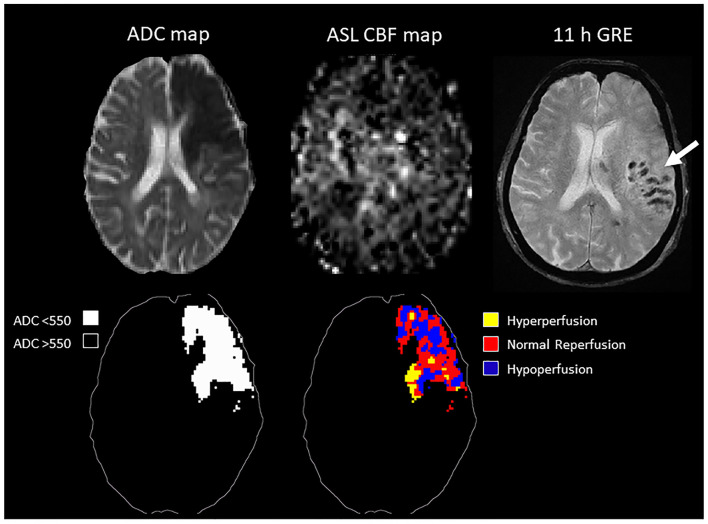
Top: MRI of an 89 year old patient with MCA occlusion. IV tPA was given 2 h from onset, followed by clot retrieval at 5.5 h from onset. Post-treatment ASL showed inhomogeneous reperfusion, and subsequent hemorrhage was observed in GRE at a later time point. Bottom: schematic drawing of the ADC-thresholded lesion volume, and the reperfusion volume distribution within the lesion.